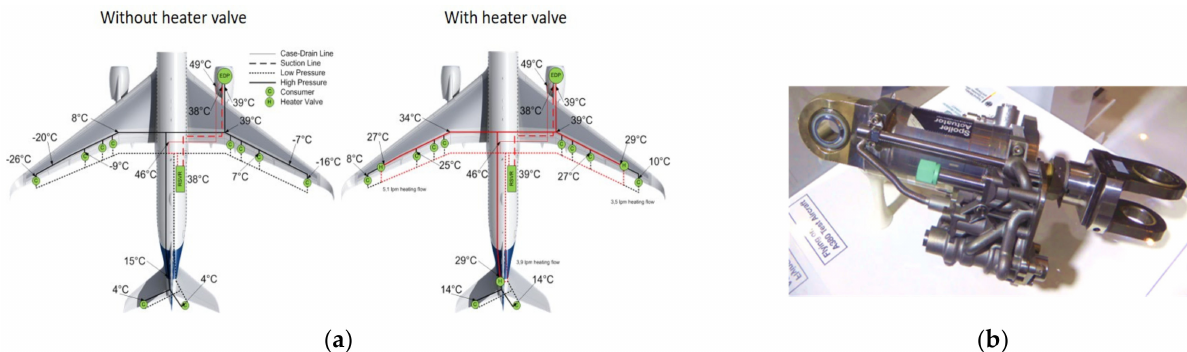
Figure 18. Margins for progress in hydraulics: ( a ) Advanced fluid thermal management with heater valves on Airbus A350 [37]; ( b ) Additive Layer Manufacturing of the hydraulic manifold of a spoiler servohydraulic